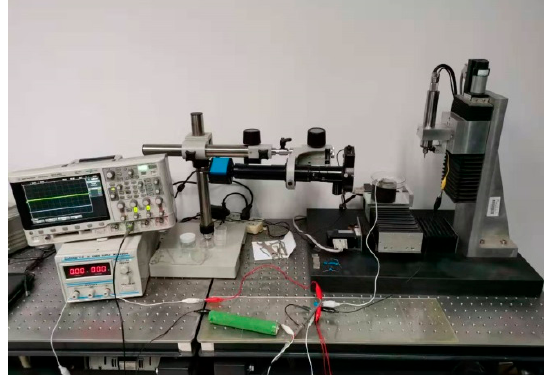
Figure 2. Image of the experimental equipment.